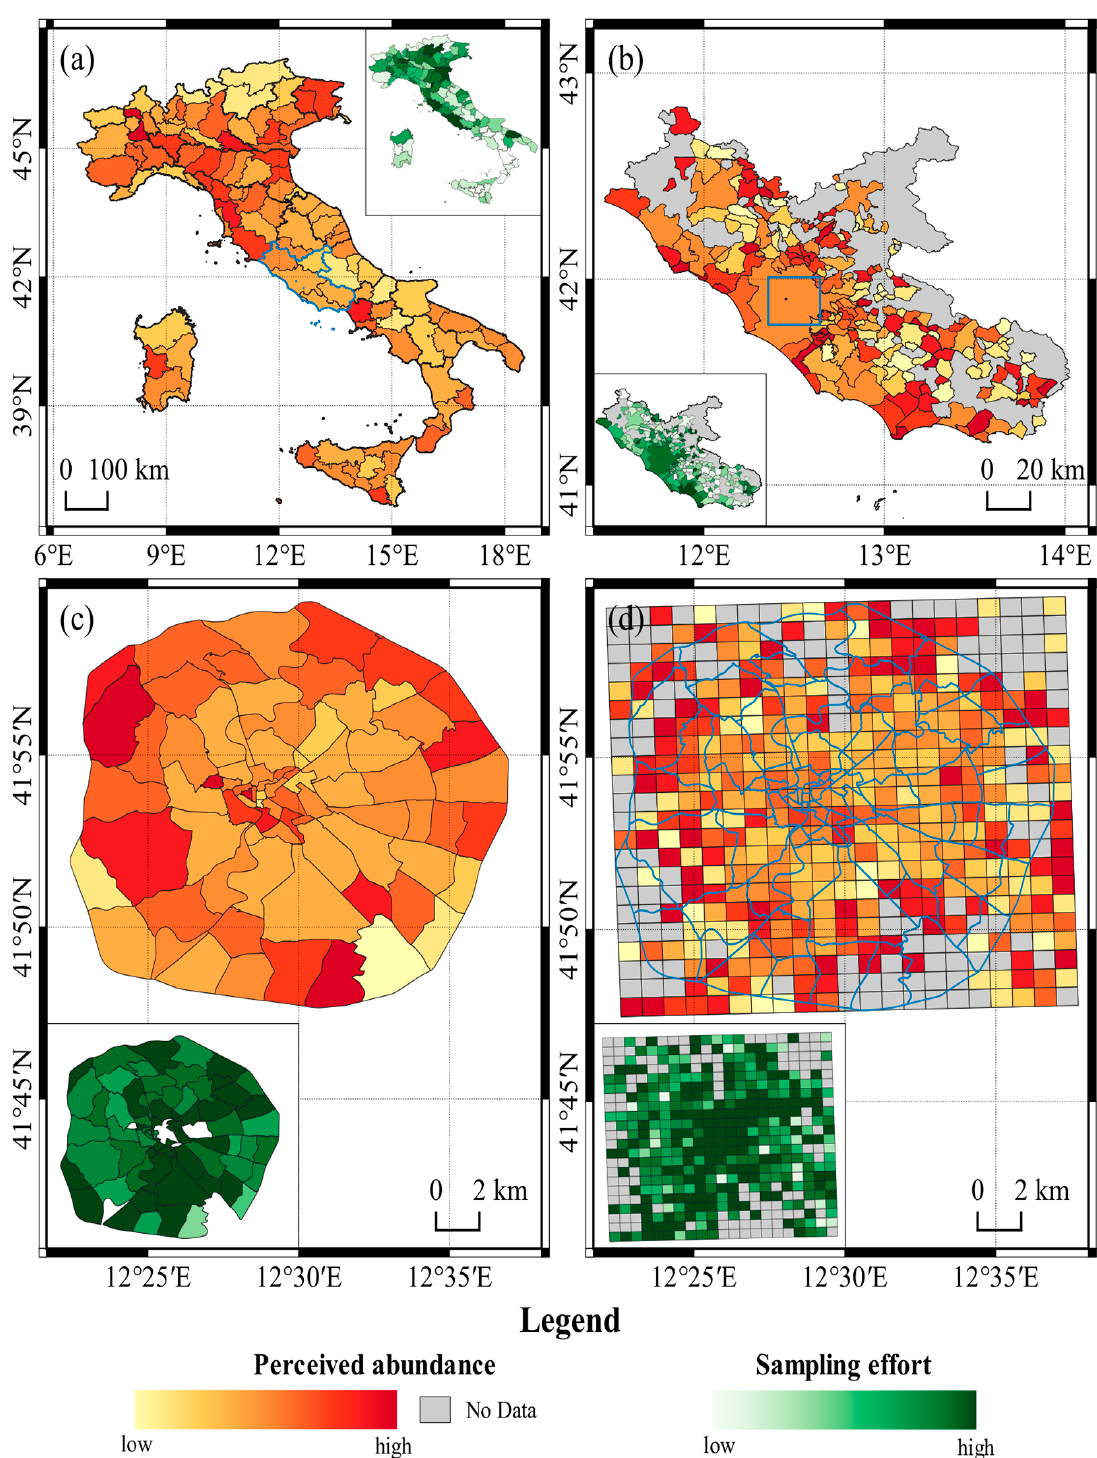
Figure 6. Scales of perceived mosquito abundance based on ZanzaMapp records (May 2016–December 2018) for Italy ( a ), Lazio region ( b ), administrative units in Rome urban area ( c ), and 1 km-spatial grid in Rome urban area ( d ). Inner squares represent maps of sampling effort, i.e., the ratio between number of ZanzaMapp records and human population.